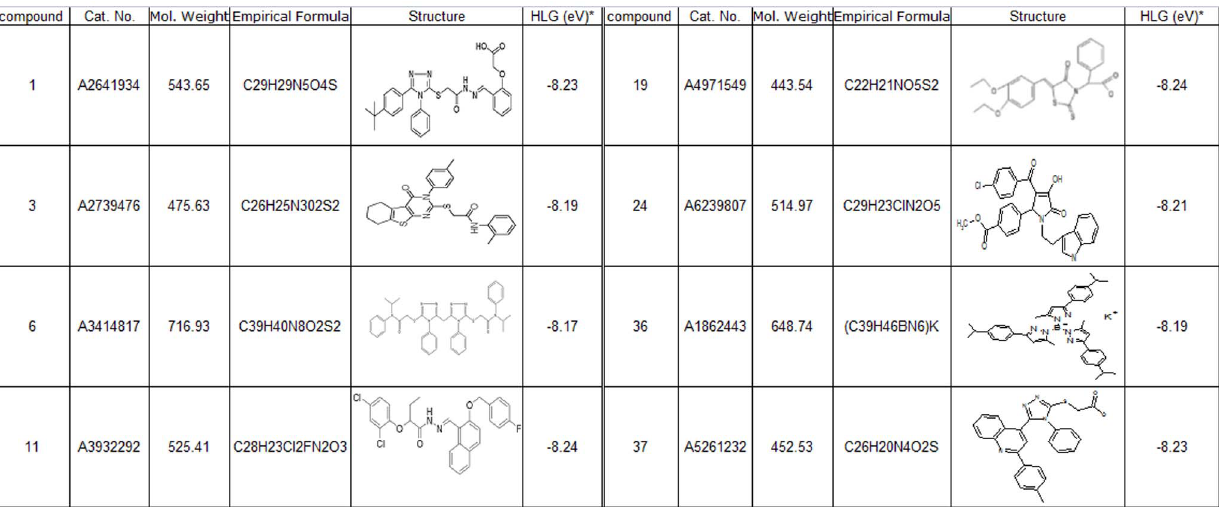
Figure 4. Molecular name, database identifier, empirical formula, 2-D structure, and topological indexes of HOMO and LUMO Gap (HLG) of the eight compounds that are able to exert dual A b -lowering and anti-oligomerization by invitro testing.